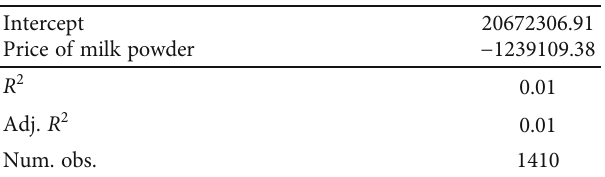
Table 1: Estimation of demand function coe ffi cients by linear